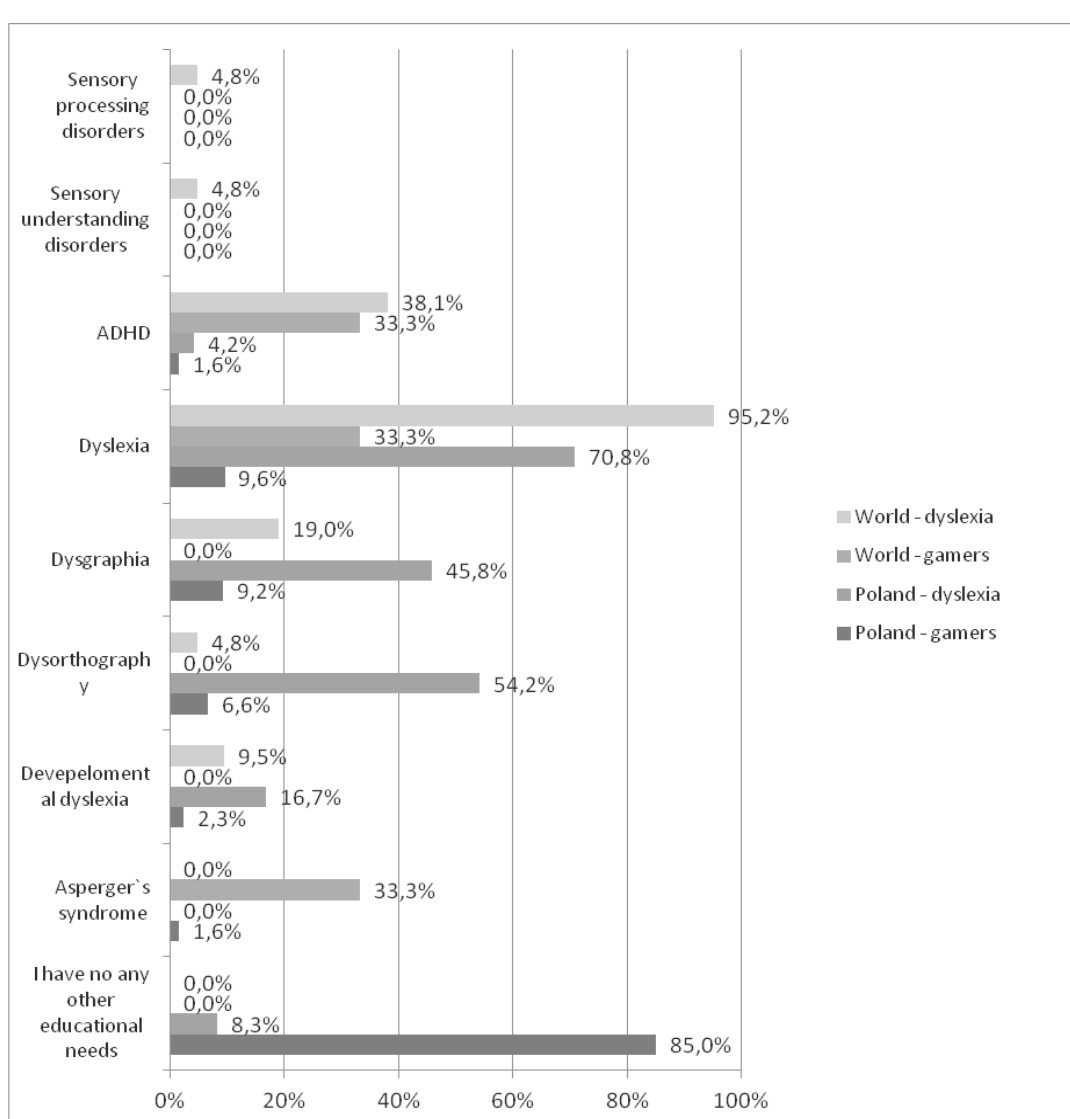
Figure 5. (cid:39)(cid:76)(cid:68)(cid:74)(cid:81)(cid:82)(cid:86)(cid:72)(cid:71)(cid:3)(cid:54)(cid:40)(cid:49)(cid:3)(cid:82)(cid:73)(cid:3)(cid:85)(cid:72)(cid:86)(cid:83)(cid:82)(cid:81)(cid:71)(cid:72)(cid:81)(cid:87)(cid:86)